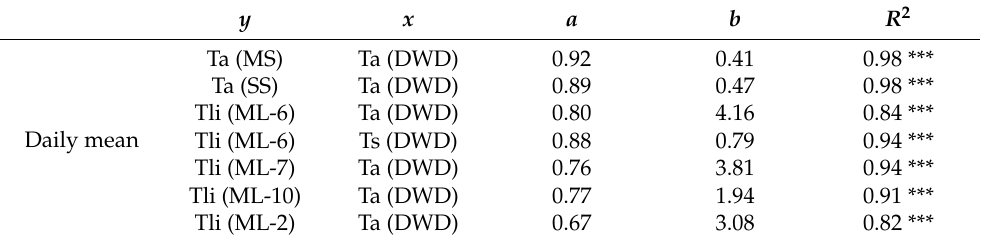
Table 4. Simple linear regressions ( y = ax + b ) for daily mean values of air (Ta), soil (Ts) and surface- near (ML) temperatures in Apr to Sep 2014 between the official weather station (DWD) and (1) stations inside the forest (MS, SS) or (2) Micro-Loggers inside (ML-2,7,10) and outside (ML-6) the forest. If R 2 was higher for DWD_Ts instead of Ta, the model is shown in the table—otherwise not. Positive values for b indicate that the DWD station was, on average, cooler than the compared site. y x a b R 2 Ta (MS) Ta (DWD) 0.92 0.41 0.98 *** Ta (SS) Ta (DWD) 0.89 0.47 0.98 *** Tli (ML-6) Ta (DWD) 0.80 4.16 0.84 *** Daily mean Tli (ML-6) Ts (DWD) 0.88 0.79 0.94 *** Tli (ML-7) Ta (DWD) 0.76 3.81 0.94 *** Tli (ML-10) Ta (DWD) 0.77 1.94 0.91 *** Tli (ML-2) Ta (DWD) 0.67 3.08 0.82